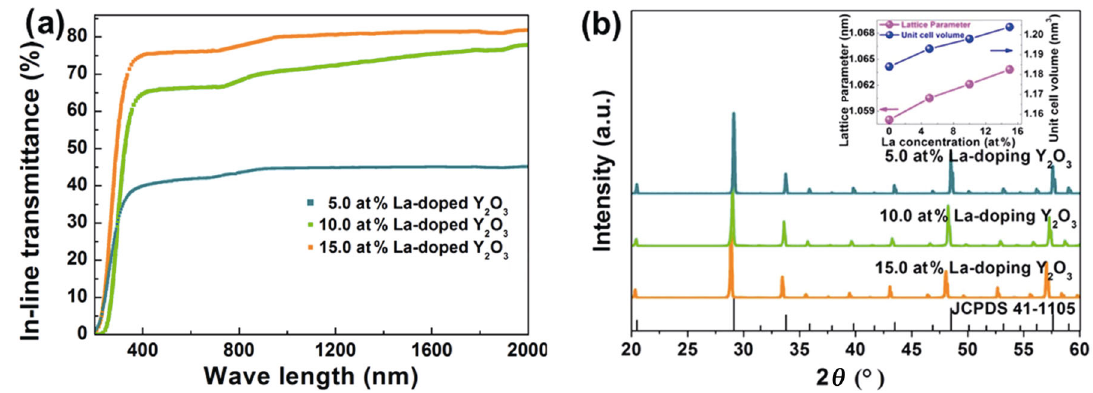
Fig. 1 (a) In-line transmittance and (b) X-ray diffraction (XRD) patterns of 5.0, 10.0, and 15.0 at% La-doped Y 2 O 3 ceramics under a sintering temperature of 1750 ℃ for 15